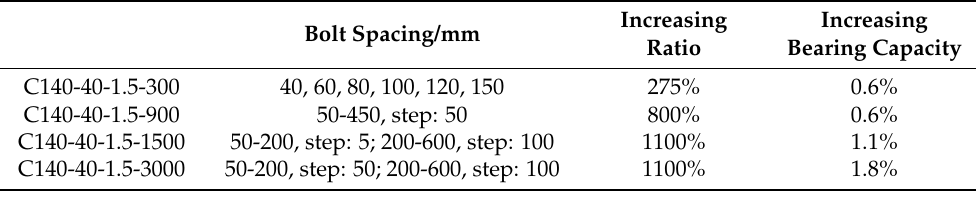
Table 3. Bolt spacings and ultimate compressive bearing capacity of combined columns.